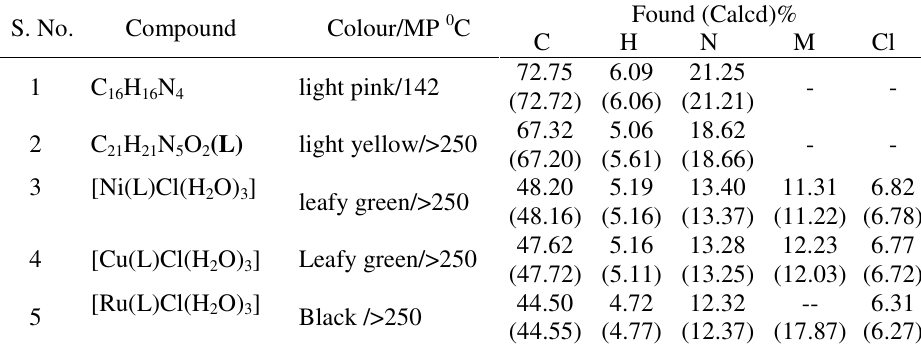
Table 1. Physical and Analytical data of Synthesized